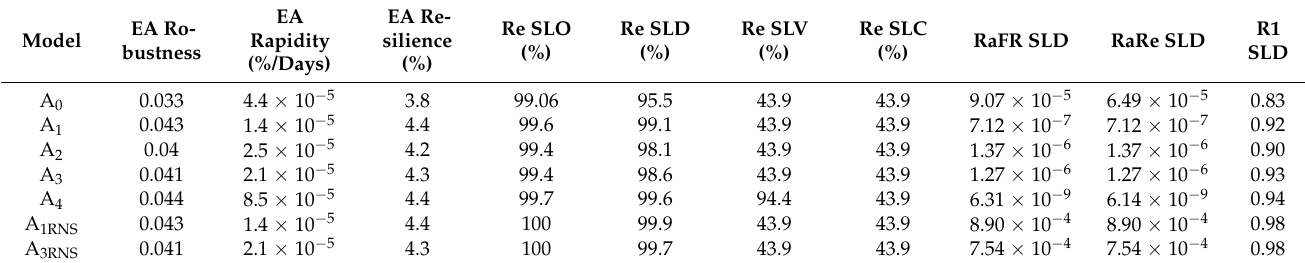
Table 4. Seismic resilience parameters.